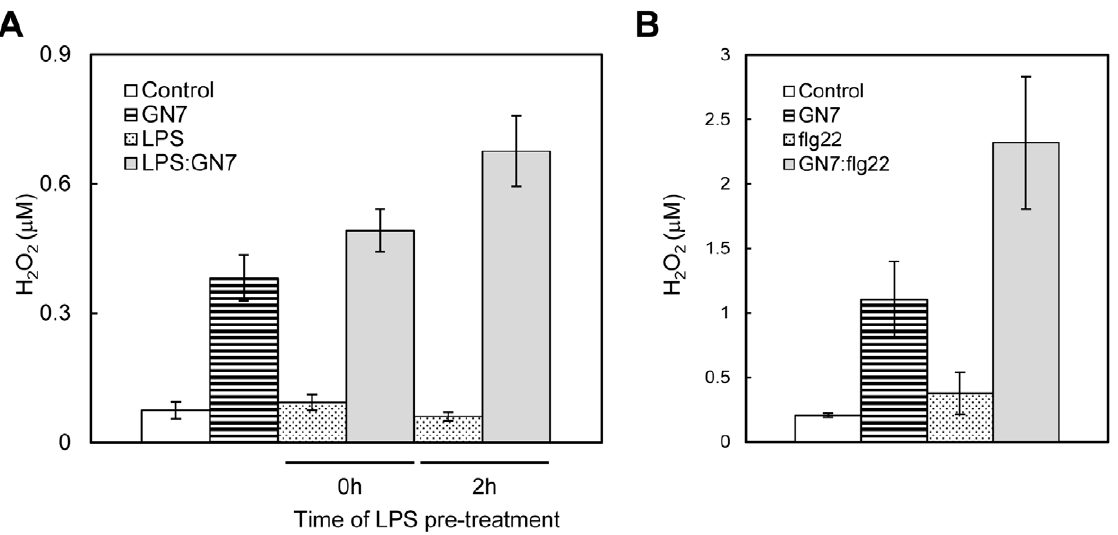
Figure 5. Synergistic effect on ROS generation in rice seedlings. (A) For priming experiments, LPS (5 m g/ml) was pretreated for 120 min before N-Acetylechitoheptaose (GN7, 10 ng/ml=6.9 nM) treatment. In the case of simultaneous treatment, both LPS and GN7 were added simultaneously. The increment of ROS in 20 min after GN7 treatment was used as the index of defense response. (B) ROS generation induced by simultaneous treatment of GN7 (10 ng/ml) and flg22 (10 ng/ml=4.4 nM).